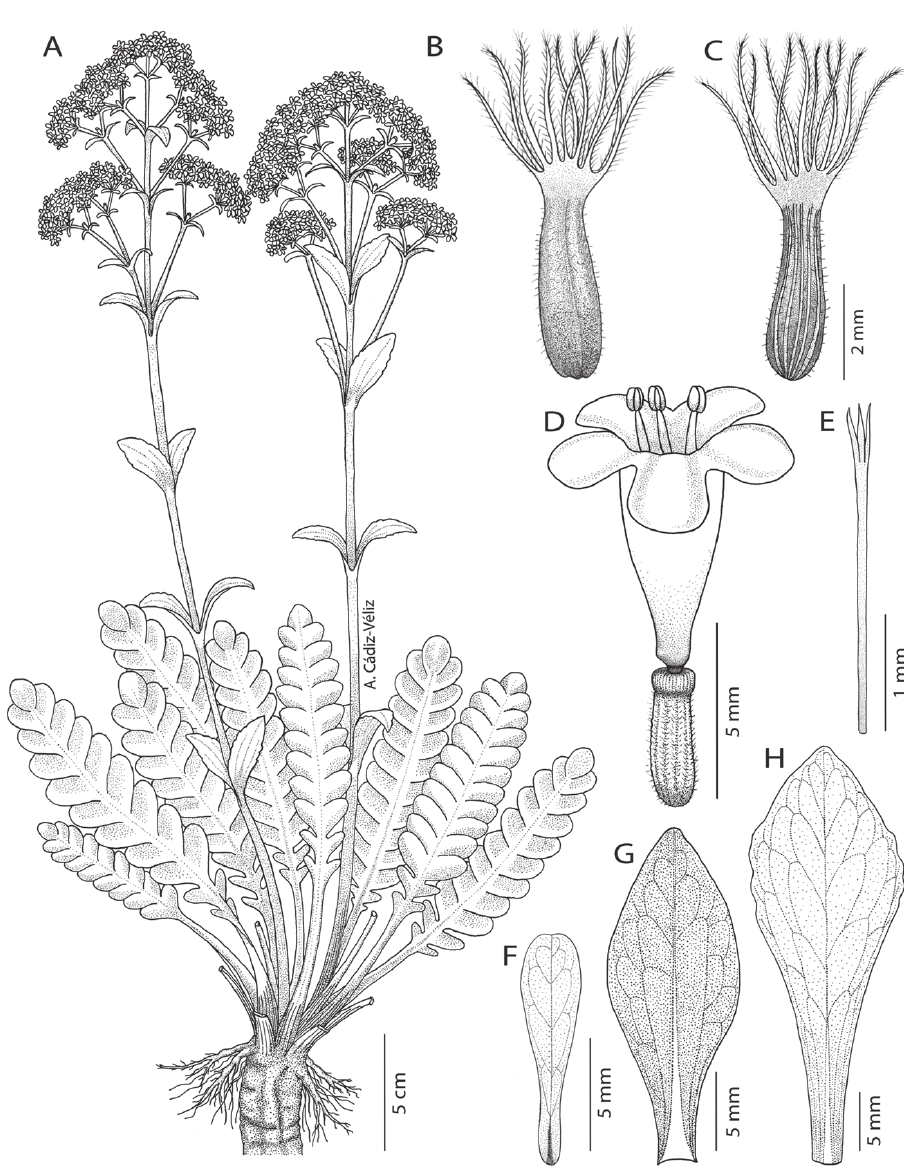
Figure 3. Valeriana praecipitis A habit B, C fruit D detail of flower E stigma F bracteole G bract H up- per leave. Drawn by Arón